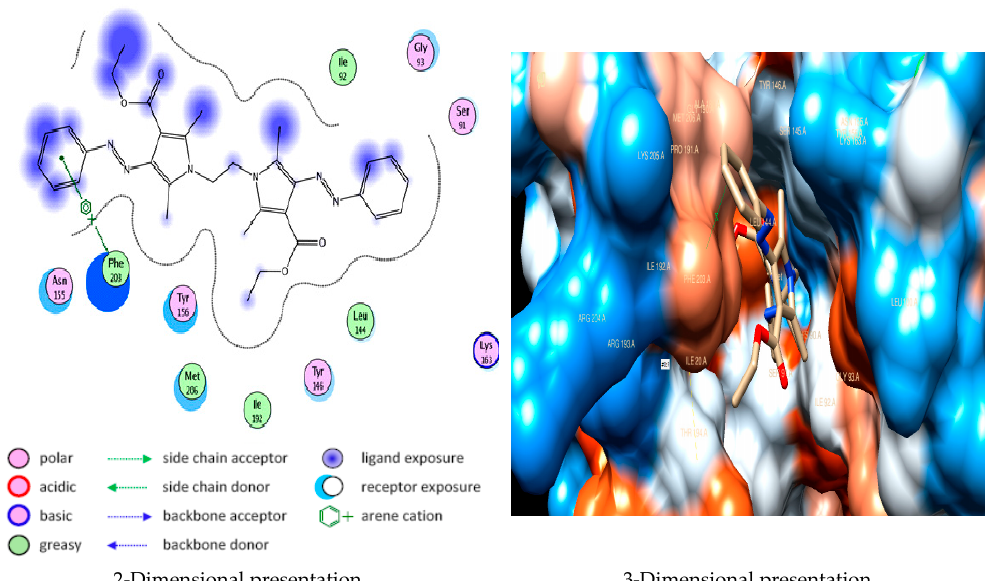
Figure 1. Docking of compound 5a into E. coli Enoyl reductase Enzyme (PDB ID: 1LXC) showing arene-cation interaction between Phe203 and the phenyl ring.